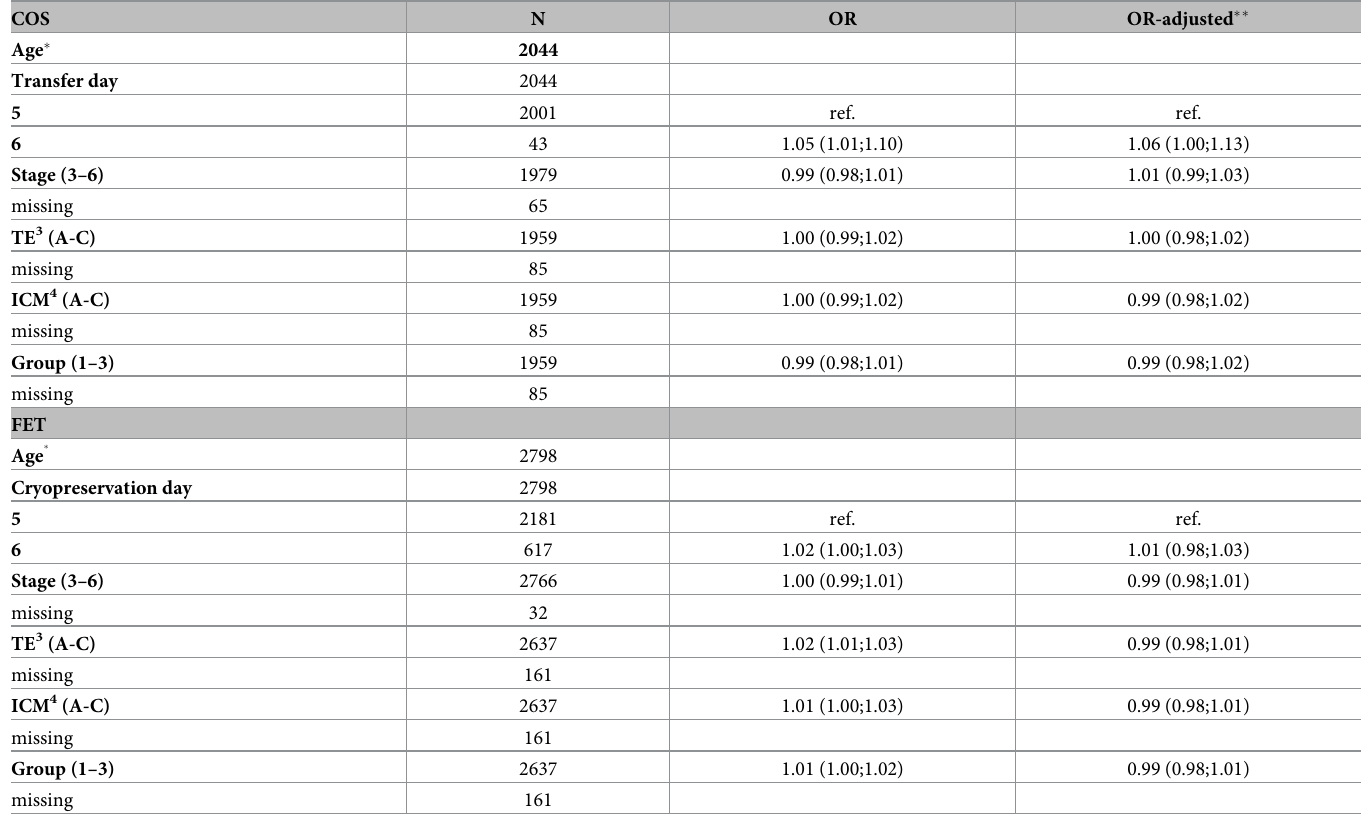
Table 2. The association of paternal age � with day of transfer, developmental stage and morphology of the competent blastocyst after COS 1 and 2